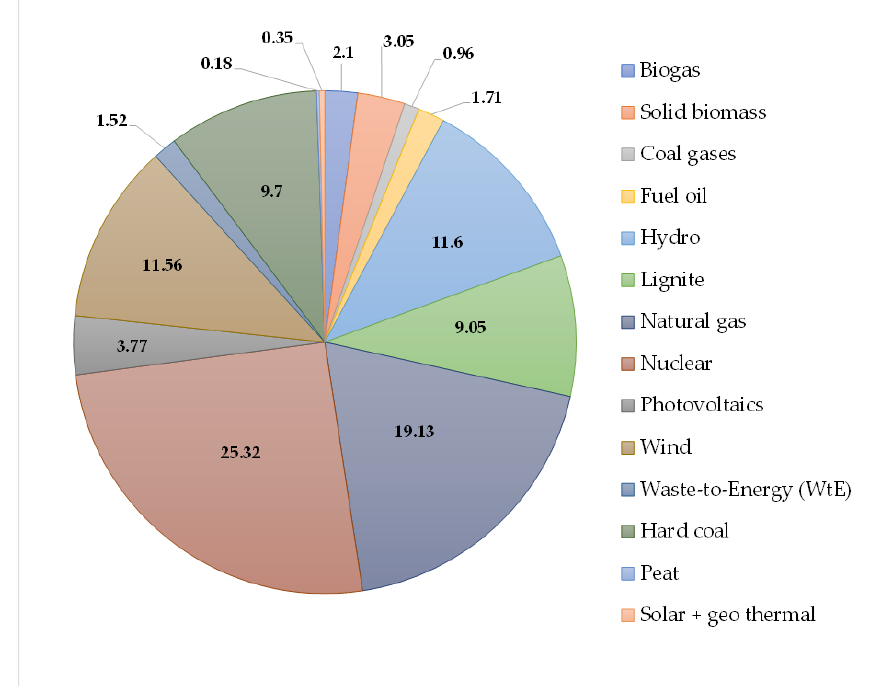
Figure 3. Electricity mix for European Union (year: 2021) (self-edited illustration).